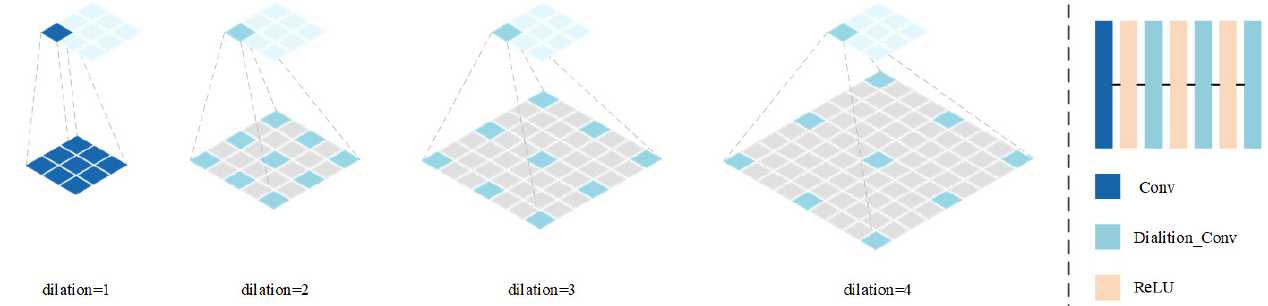
Figure 3. Neural network based on dilated convolution and receptive fields with different dilation rates.